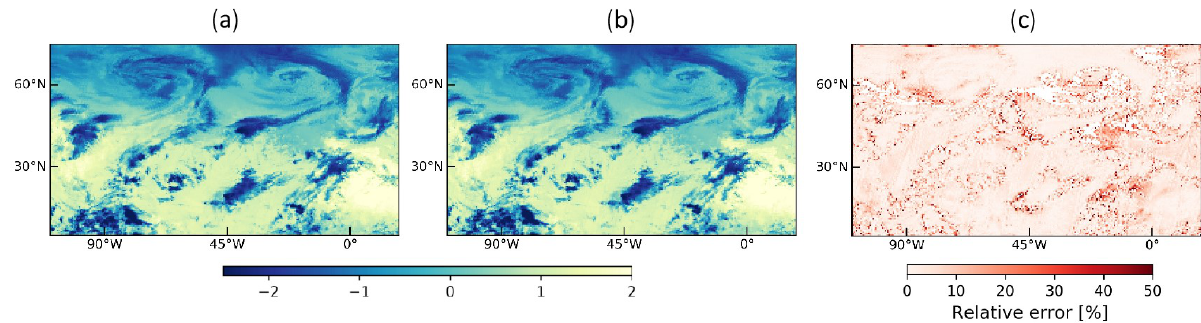
Figure 8. Visualization for one channel (wavenumber at 969.75 cm − 1 ) and for one image of the vali- dation set. ( a ) Normalized original image. ( b ) Reconstructed image by the autoencoder. ( c ) Difference between normalized original image (panel a) and its reconstruction by the autoencoder (panel b). Due to the normalization, the values shown in panels a and b are